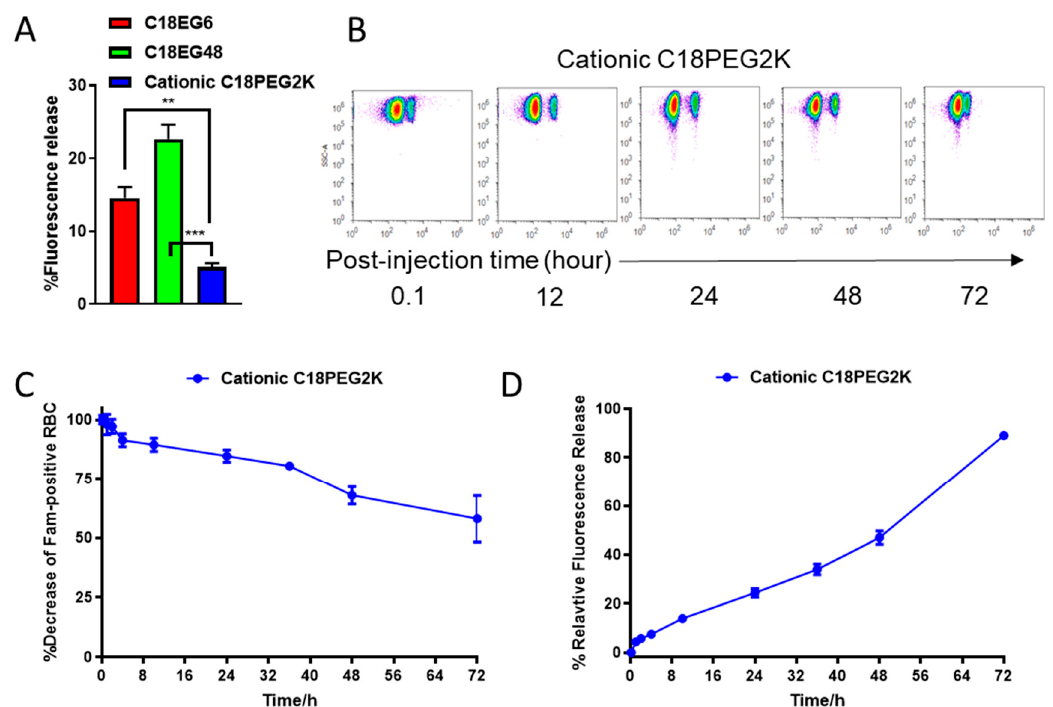
Figure 4. Cationic lipid prolongs the retention time of long PEG amphiphiles in vitro and in vivo. ( A ), Percentages of release cationic C18PEG2K after in vitro culture with whole blood. ( B – D ) Representative flow cytometry dot plots ( B ) and relative frequencies of Fam-positive RBCs ( C ) and mean fluorescence intensities ( D ) at different time points after injection. Each time point was assayed with three replicates. Error bars represent the SEM. *, p < 0.05; **, p < 0.01; ***, p < 0.001; ****, p < 0.0001; ns, not significant.